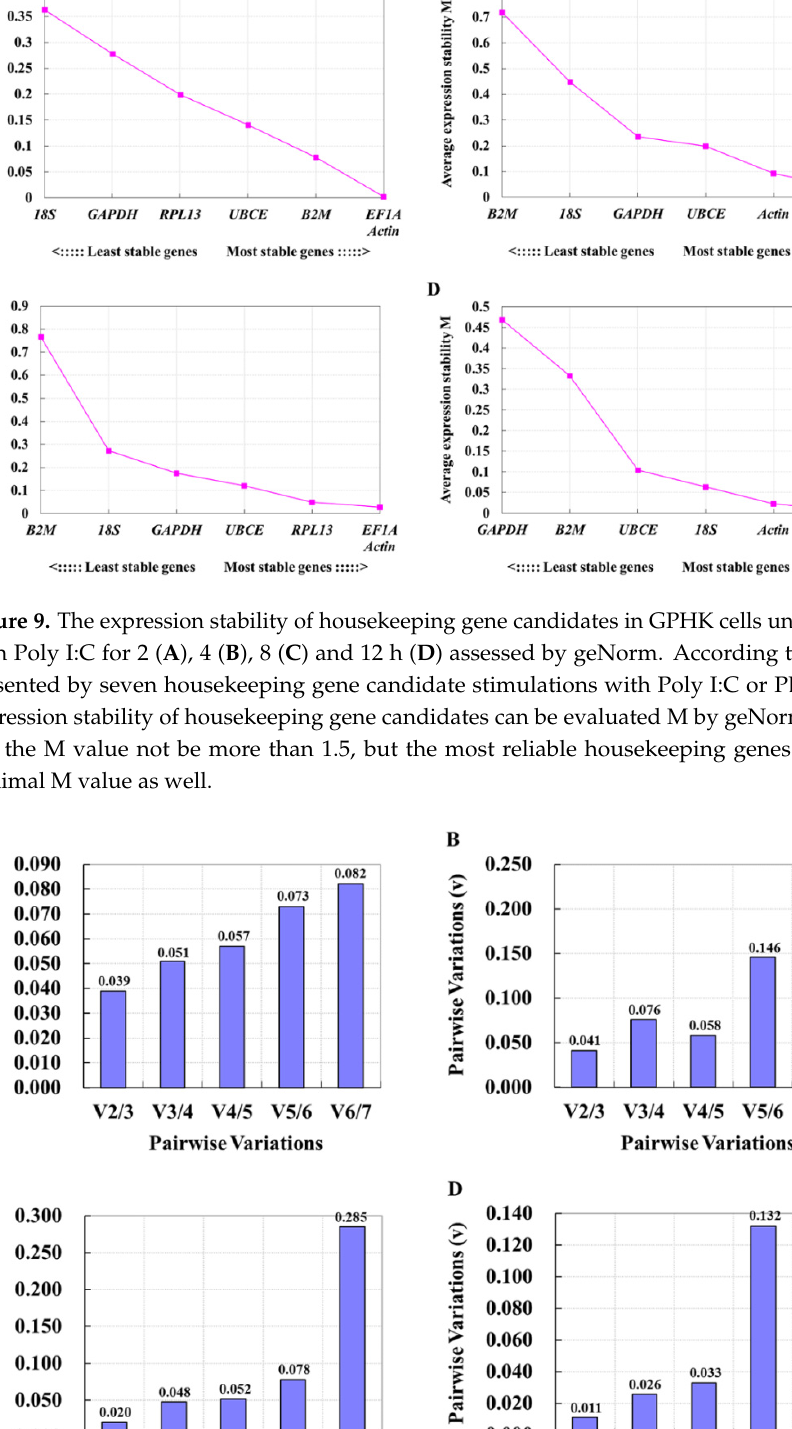
Figure 8. Optimum pairs of housekeeping gene candidates necessitated for normalization in GPS cells under stimulation with Poly I:C for 2 ( A ), 4 ( B ), 8 ( C ) and 12 h ( D ) according to geNorm analysis. The optimal number of reference genes depends on the V n/n+1 value via geNorm analysis; moreover, the value is popularly less than 0.15.